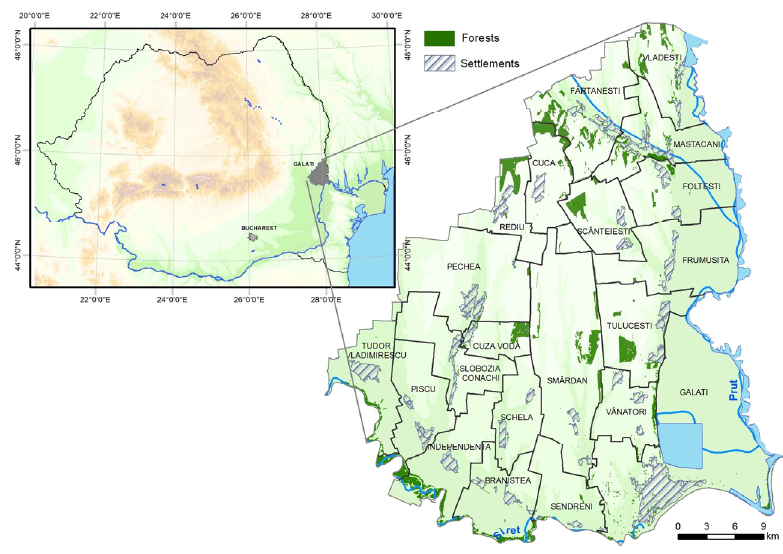
Figure 2. Gala ț i urban and peri-urban